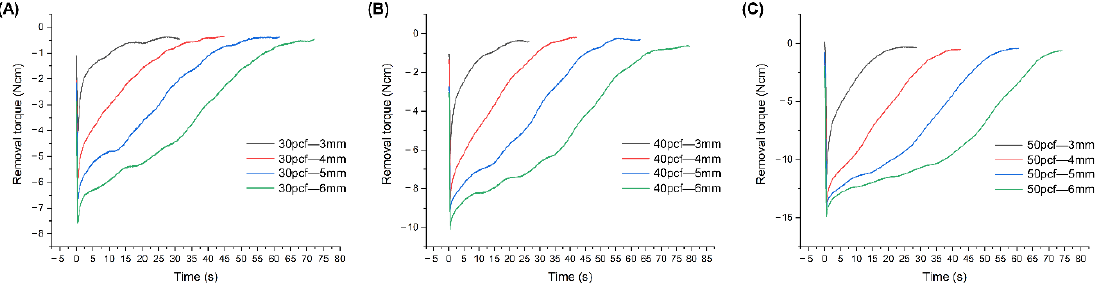
Figure 6. Removal torque values of time in ( A ) 30, ( B ) 40, and ( C ) 50 pcf cortical bone.